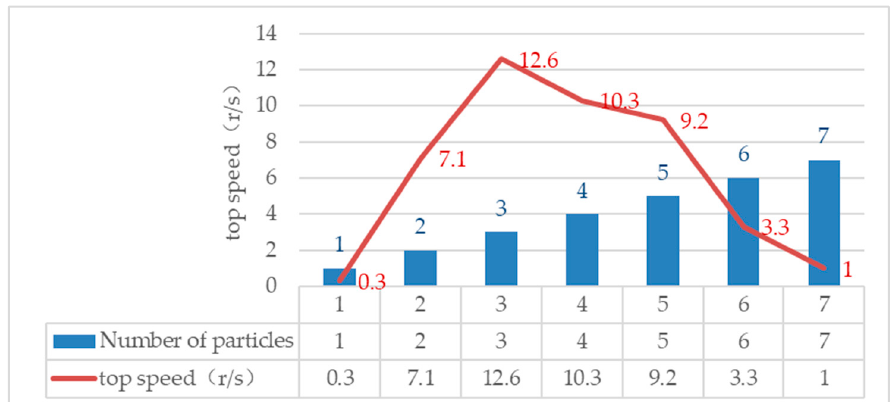
Figure 10. Number of particles and maximum speed.